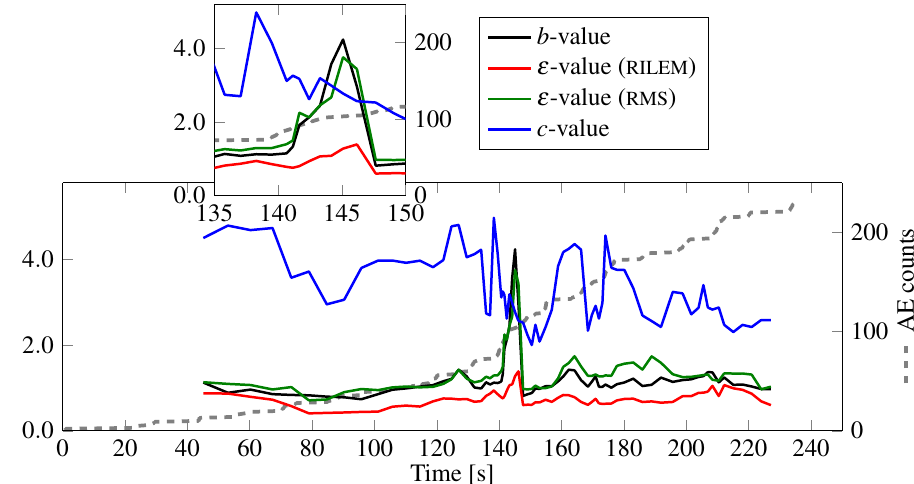
Figure 12. Time evolution of value- b , value- (cid:101) and value- c